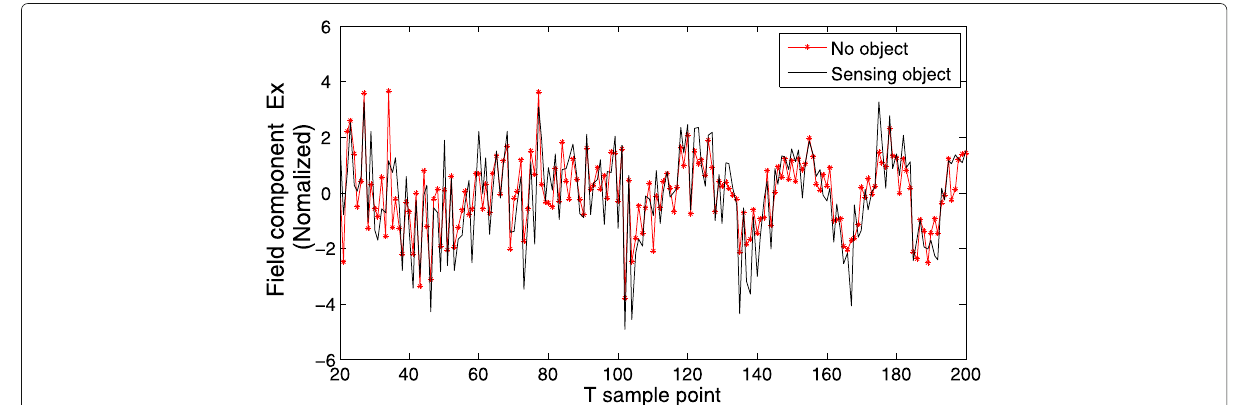
Fig. 3 Difference in received signal caused by sensed object